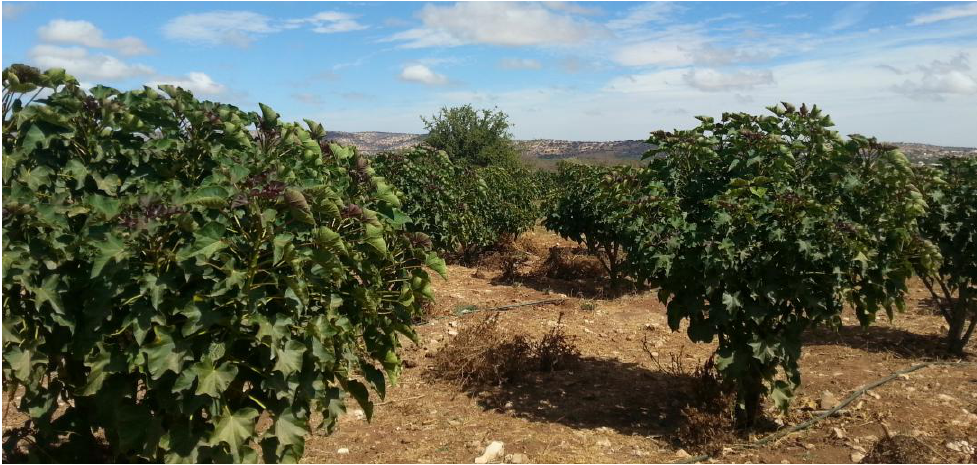
Figure 1. Picture of the three years old jatropha plants of the Mali genotype where the pruning wood samples were collected (31°33′13.6′′ N 9°32′44.0′′ W—Morocco).